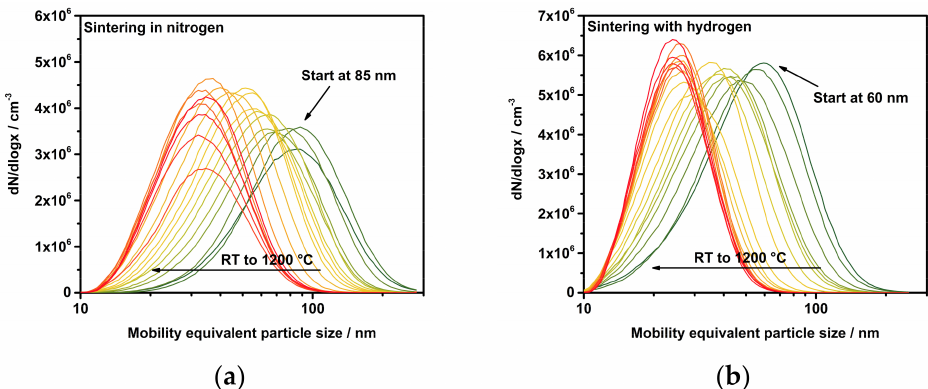
Figure 3. Sintering curves for platinum particles in nitrogen ( a ) and with hydrogen ( b ).